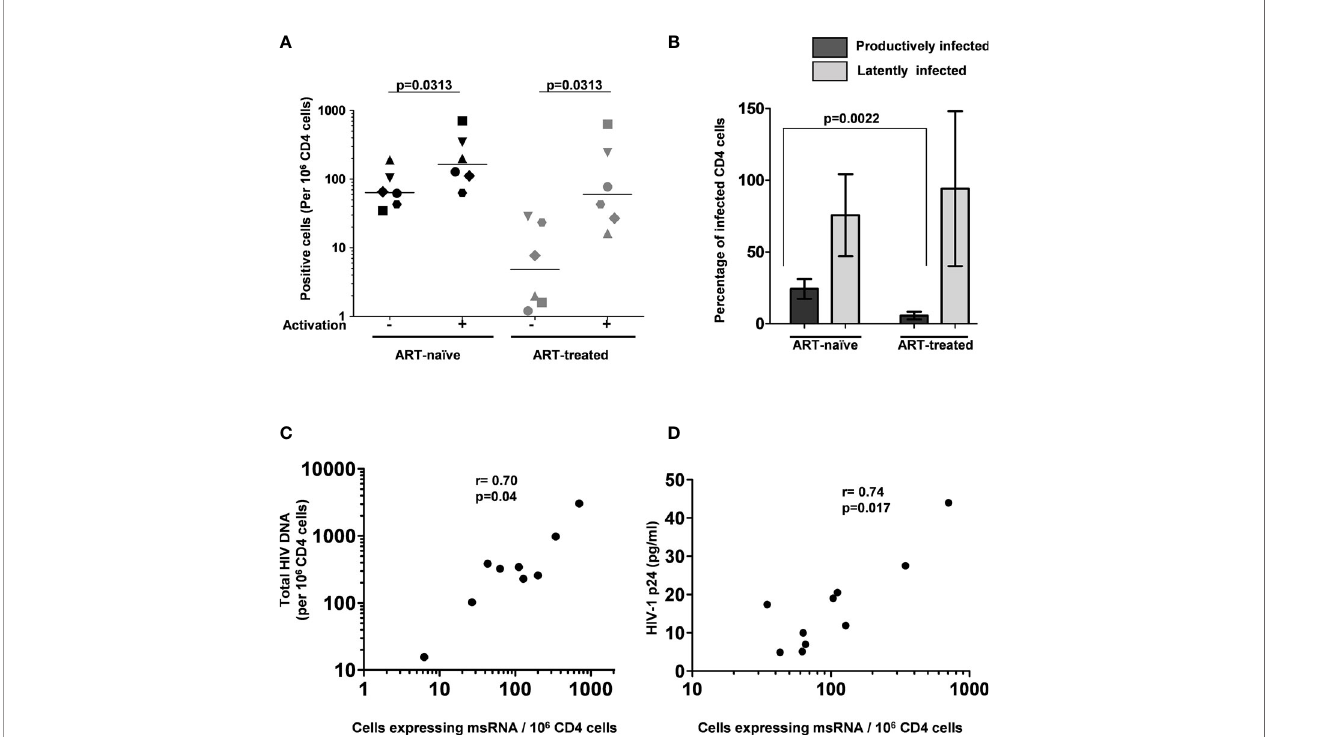
FIGURE 5 | The frequency of persistently infected cells in donor blood samples. (A) The frequency of CD4 + T cells producing msRNA spontaneously (No activation) or after 12 h of stimulation (activation) in ART-naïve (n=6) and ART-treated (n=6) participants. Each symbol represents a donor. The horizontal bars represent the median values of the positive cell frequency. Wilcoxon matched-pairs signed-rank test was used for statistical analysis. (B) Histograms depicting the percentage of productively and latently infected CD4 + T cells in ART-naïve and ART-treated participants (mean ± SEM). P-value was obtained from the Mann – Whitney test. (C) Correlation between msRNA-producing CD4 + cell number and total HIV-1 DNA copies. Genomic DNA extracted from CD4 + cells of nine study participants was used to quantitate the total HIV-1 DNA load using a ddPCR format as described in materials and methods. In parallel, the number of CD4 + cells expressing viral transcripts was evaluated using the U-TILDA format. Each dot represents a study participant. Spearman ’ s rank correlation analysis was performed to estimate the correlation. (D) Correlation between msRNA-producing CD4 + cell number and p24 production from the cells. Each dot represents one of the nine study participants used in the assay. The number of CD4 + cells expressing viral transcripts was determined as in panel (C) The amount of p24 secreted into the medium by one million enriched CD4 + cells after three days following the activation with PMA (100 ng/ml) and Ionomycin (1 µg/ml) was determined using a commercial kit. Spearman ’ s rank correlation analysis was performed to estimate the